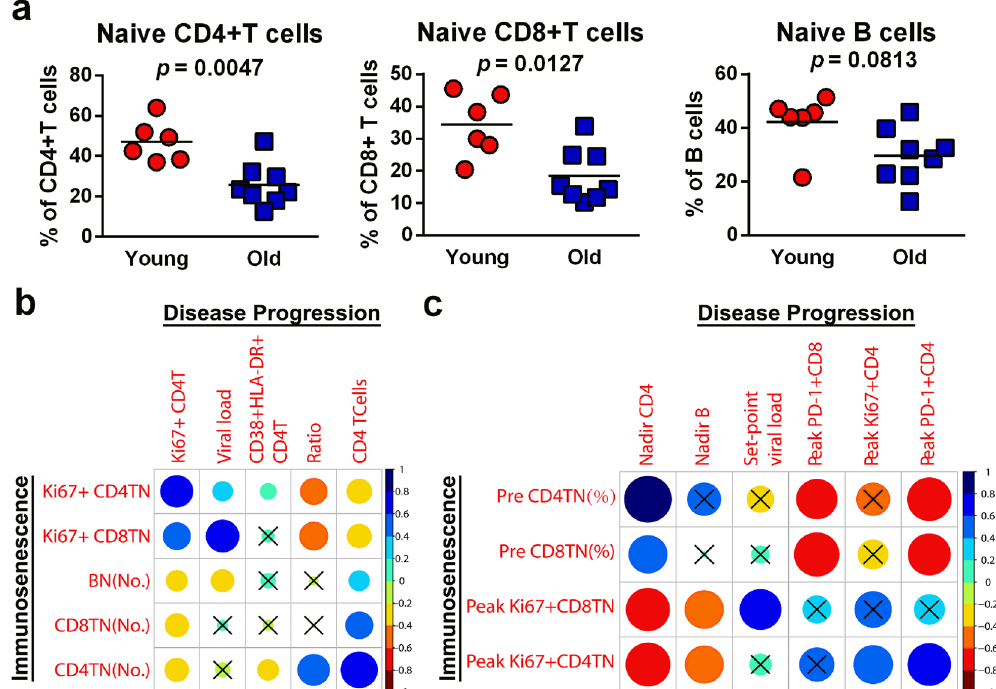
Figure 5. Immunosenescence predicts accelerated disease progression in old ChRM. ( a ) Old ChRM have a significantly lower frequency of naïve CD4 + and CD8 + T cells and naïve B cells than young ChRM before infection. P values were determined using the Mann-Whitney t-test. ( b ) The correlation matrix constructed by package corrplot with R reveals the relationships between the markers of immunosenescence and SIV disease progression during infection. ( c ) The correlation matrix reveals the relationships between characteristic values before and after infection. Pre, value before infection; Peak, peak value during infection; Nadir, minimum value during infection. The blue and red indicate positive and negative correlations, respectively (see color bar). The results of Spearman’s test (two-tailed, unadjusted) with a P value ≥ 0.05 were considered not significant (shown as